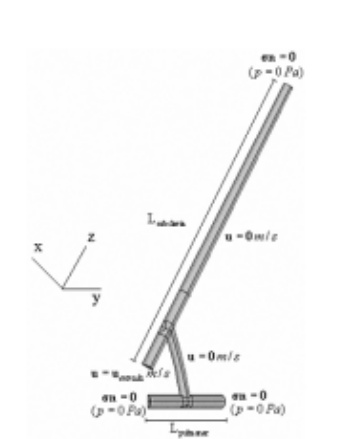
Fig. 1 - Optimal lengths of the subclavian artery (Lsubclavian = 152 mm) and of the pulmonary artery (Lpulmonary = 40 mm) in the model used for computerized analysis